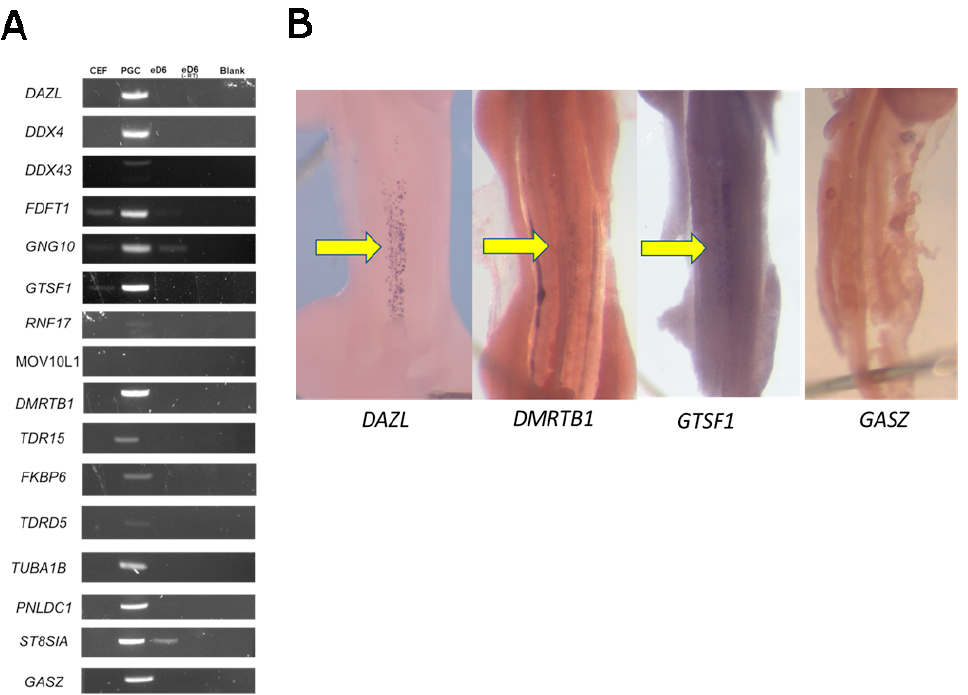
Figure 2. Validation of germ cell-specific expression. ( A ) An RT-PCR analysis was performed for 16 protein-coding genes in chicken embryonic fibroblasts (CEF), chicken embryos of day 6 (eD6) without mesonephroi, cultured chicken primordial germ cells (PGC), and chicken day six embryos without the reverse transcriptase enzyme eD6 (-RT). ( B ) Whole-mount RNA in-situ hybridization for candidate germ cell-specific genes on chicken embryos. A specific signal was detected for the DAZL , DMRTB1, and GTSF1 probes, but GASZ showed no or non-PGC-specific expression. The yellow arrows indicate the genital ridges with labeled